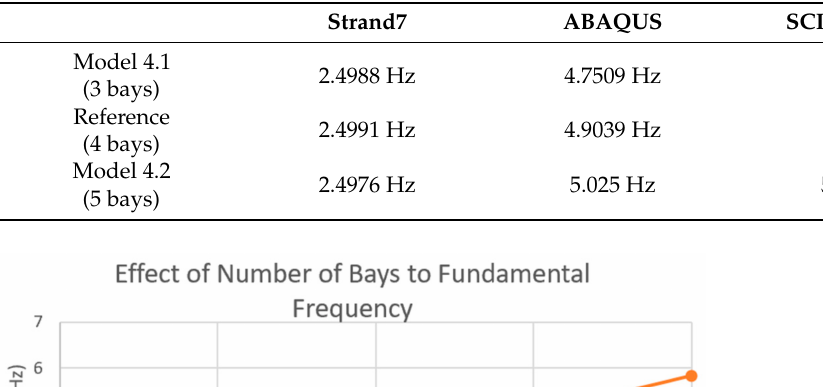
Table 9. Comparison of Fundamental Frequency between Different Numbers of Bays.